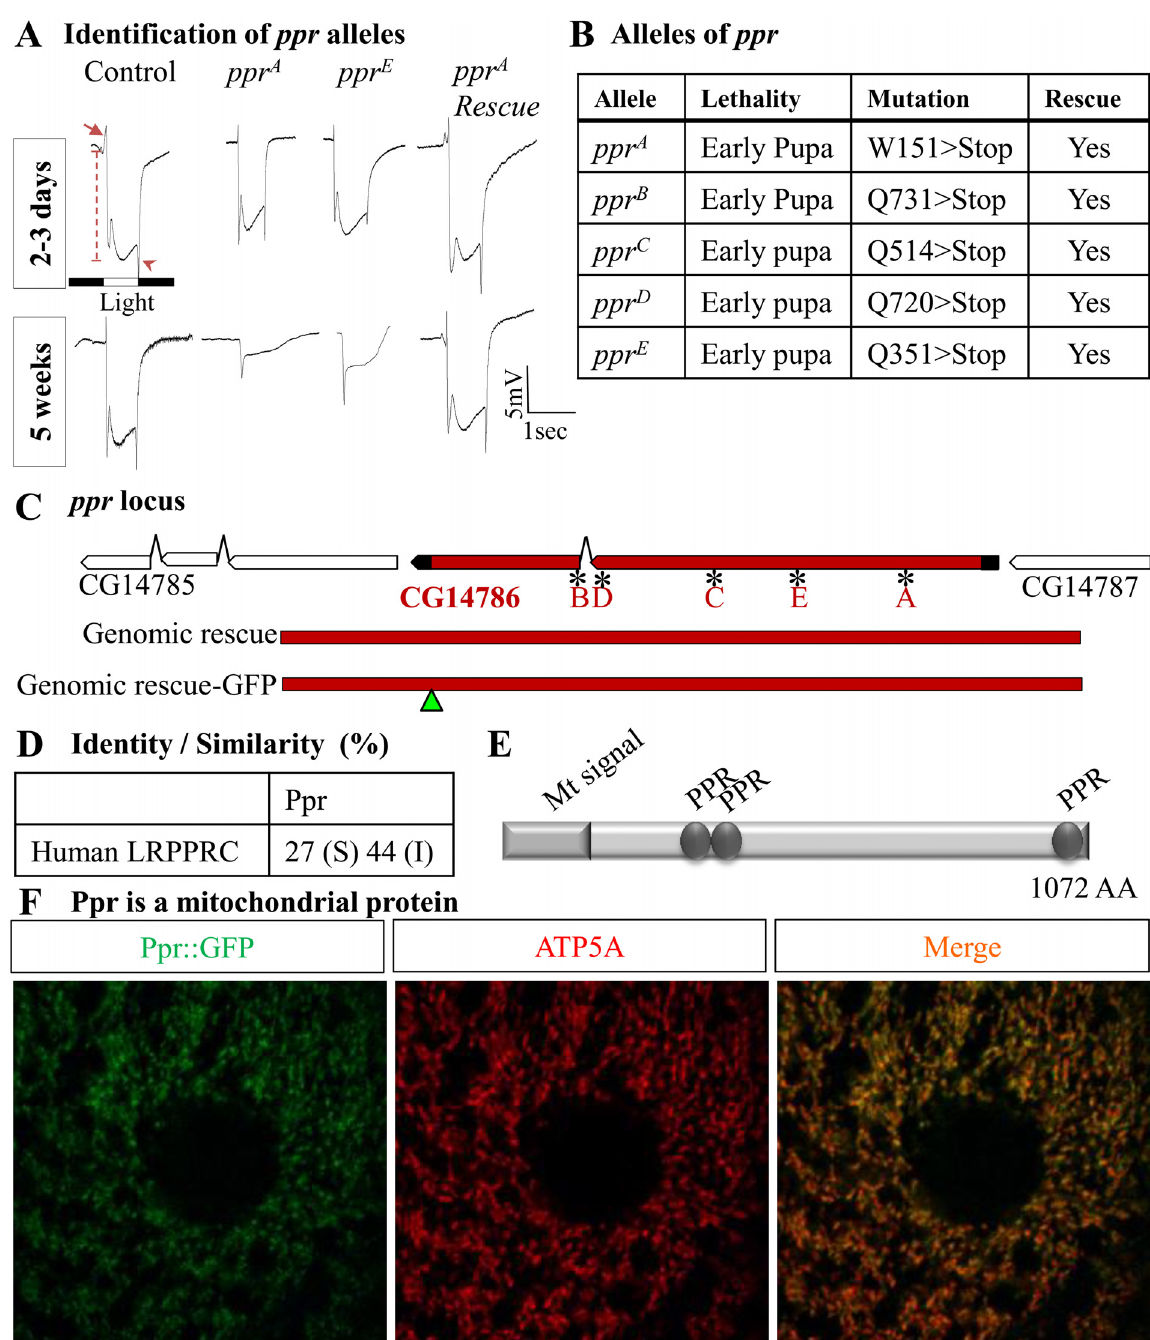
Fig 1. Mutations in ppr cause PR degeneration. (A) ERG traces from eye clones of control ( y w FRT 19A), ppr A , ppr E , and ppr A -carrying genomic transgene (CH322-75O21)-containing wild-type ppr ( ppr A Rescue ). Arrow and arrowhead indicate “ on ” and “ off ” transient respectively. Dashed line indicates the amplitude. Top: upon eclosion, flies were raised in dark for 2 – 3 d, after which ERGs were recorded. Bottom: flies were reared for 5 wk in a 12 h light/12 h dark cycle. (B) Table presenting all identified ppr alleles, their lethal stage, and molecular lesion. Lethality in these alleles is rescued by a genomic copy of ppr or ubiquitous expression of ppr cDNA. (C) Genomic location of the ppr ( CG14786 ) gene, displaying the position of the molecular lesions associated with the different alleles. The genomic rescue construct spans a region from 0.3 kb upstream to 1.3 kb downstream of the ppr coding region. The genomic rescue- Green Fluorescent Protein (GFP) construct contains a GFP tag at the C-terminus of ppr . (D) The Ppr protein has 27% identity (I) and 44% similarity (S) to human LRPPRC. (E) The Ppr protein ’ s predicted mitochondrial localization signal and PPR repeats are shown. (F) Colocalization of the GFP-tagged Ppr protein (green) with mitochondrial complex V (ATP5A antibody, red) in larval